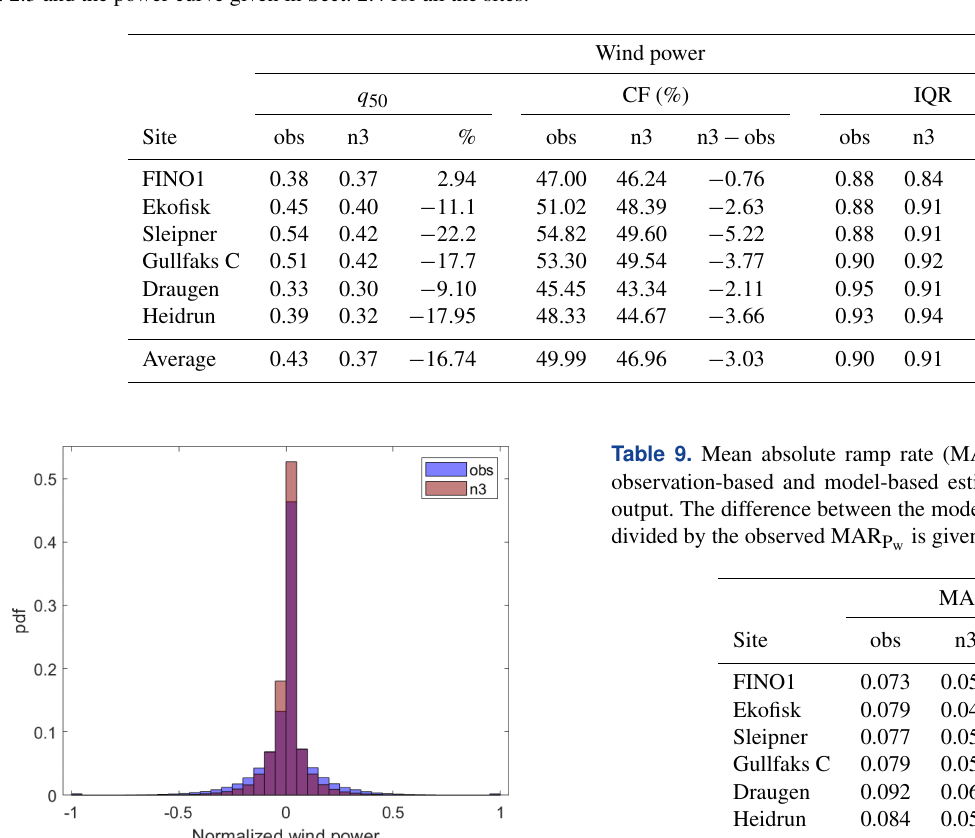
Table 8. Statistical measures of the observation-based (obs) and model-based (n3) normalized wind power production. q 50 is the hourly median production, IQR is the interquartile range of the hourly production, and CF is the wind power capacity factor. The wind power measures and estimates are performed at a typical hub height of 100ma.s.l. using the interpolation of observed wind speeds as outlined in Sect. 2.3 and the power curve given in Sect. 2.4 for all the sites.